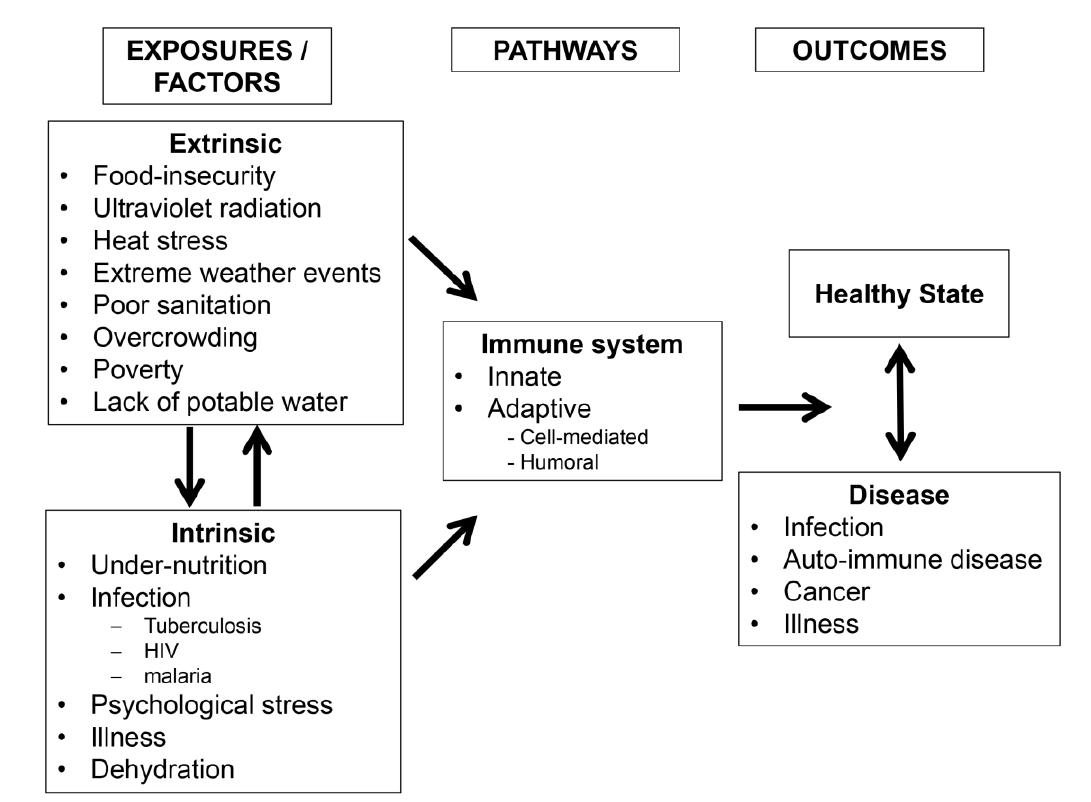
Figure 2. The developing immune system can be influenced by extrinsic and intrinsic exposures and physiological states that can lead to adverse health